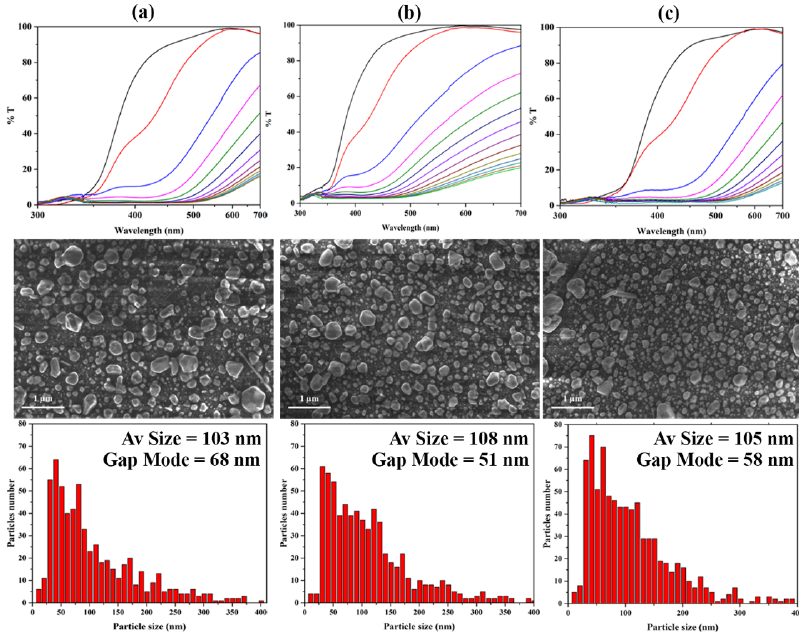
Figure 6. UV–Vis transmittance spectra showing the plasmonic dip evolution from 0 min. (black curve, water filled chip) to the final reaction time, with 1 min step (the same colour sequence is used in all graphs, starting from the red curve, corresponding to the silver precursor injection), FESEM micrographs, and particle size distributions of the samples synthetized in dynamic conditions using a 100 mM AgNO 3 at 20 ◦ C, employing a flow rate of ( a ) 1 mL/min, ( b ) 2 mL/min, and ( c ) 3